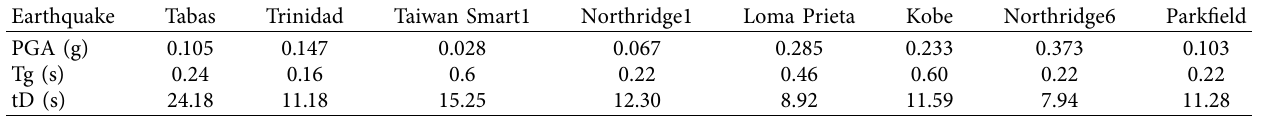
Table 22: Parameters and efective characteristics in the response of models under artifcial SS. Earthquake Tabas